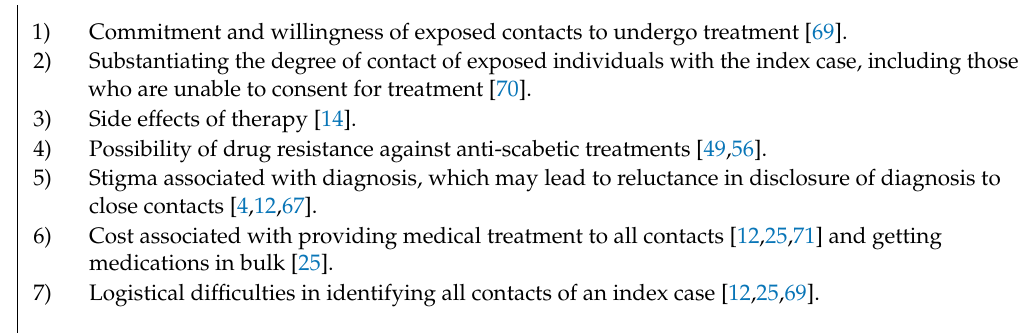
Table 3. Concerns and challenges in mass